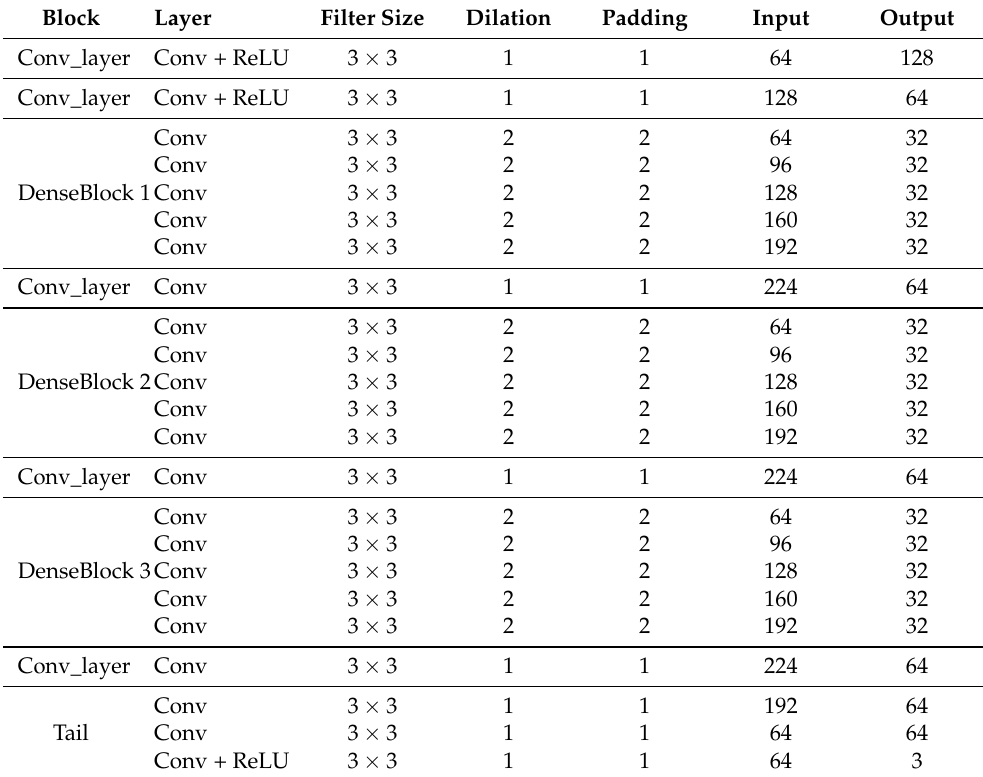
Table 1. Architecture of the decoder, where Conv represents the convolutional layer. The last two columns represent the number of input and output channels, respectively. Block Layer Filter